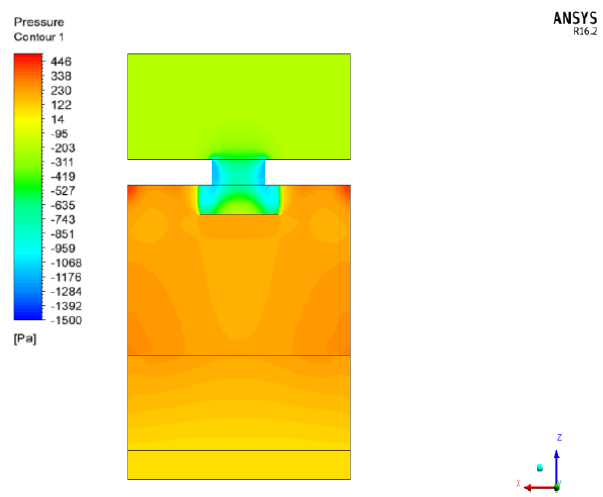
Figure 5. Static pressure contour at medium height of the AHU. The static pressure in the fan volute reaches very low values. In this zone, the dynamic pressure component is also important due to the high passing air velocity. In terms of static pressure field calculated, it is seen, as mentioned previously, that an average value of static pressure is set in the fan zone